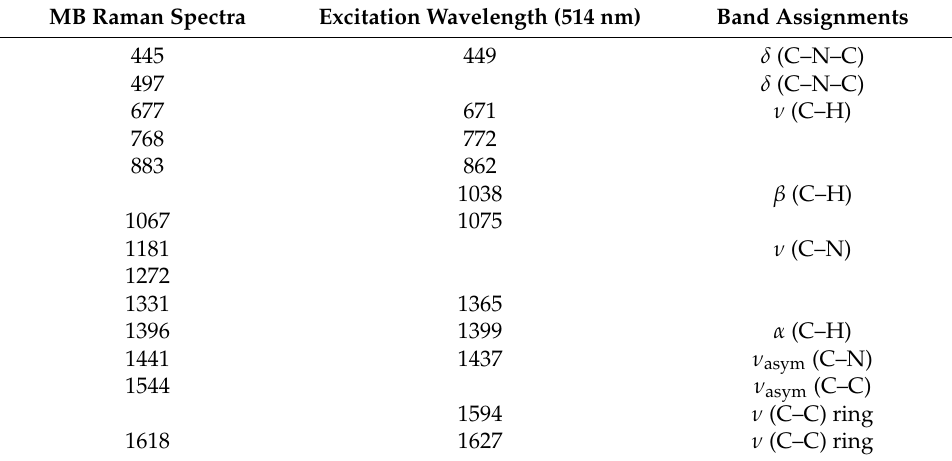
Figure 5. ( a ) SERS spectra of MB (10 − 3 mol/L) adsorbed on PSCP@Ag-FeS arrays with different FeS sputtering powers, the triangle-marked peaks were attributed to Si Wafer; ( b ) the ratios of the sputtering power of FeS to the Raman intensity of MB (taking 1627 cm − 1 as an example). Table 1. Raman and SERS bands and band assignments of MB.